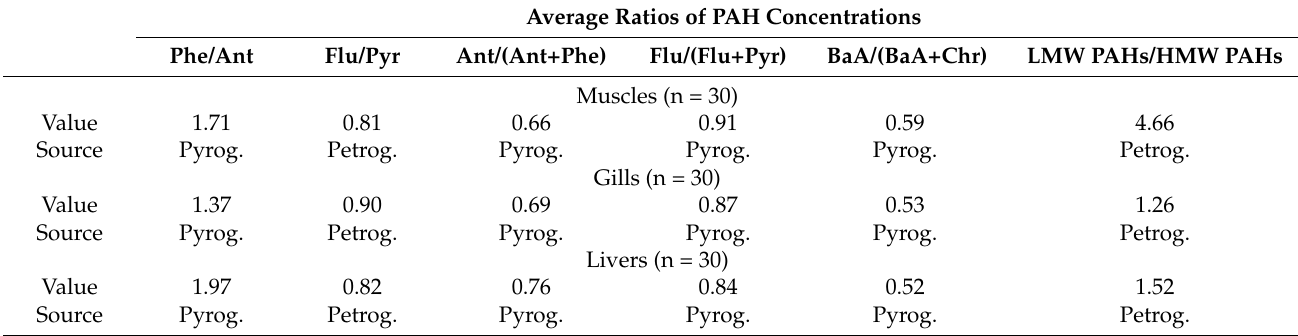
Table 4. Results of the various PAH concentration ratios and the probable source.